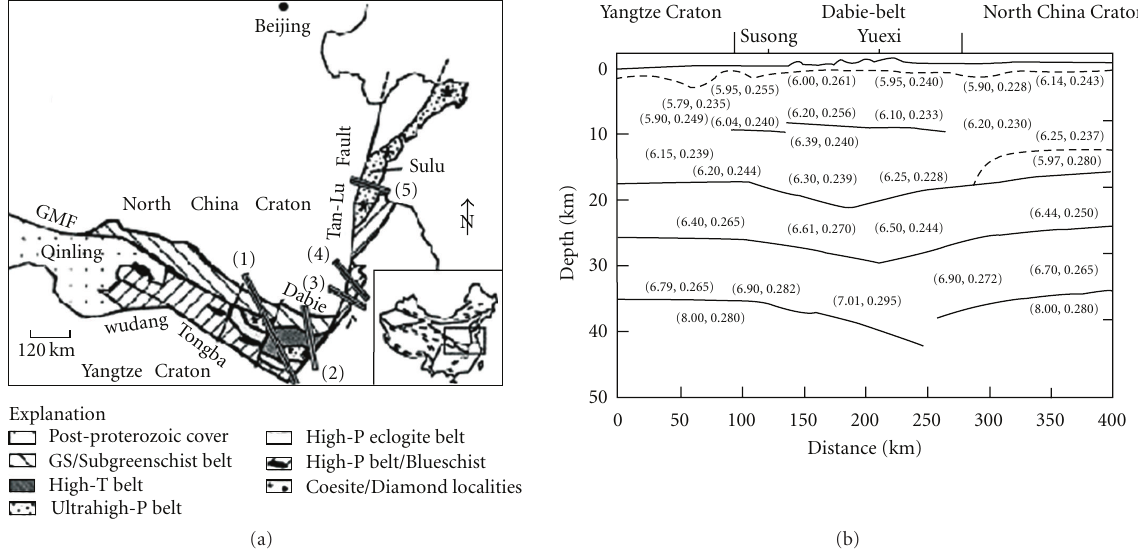
Figure 5: Regional map (a) of the Dabie-Sulu area [24] and a seismic model structure for P-wave velocities and Poisson’s ratios (b) for the 34 km thick crust [25].